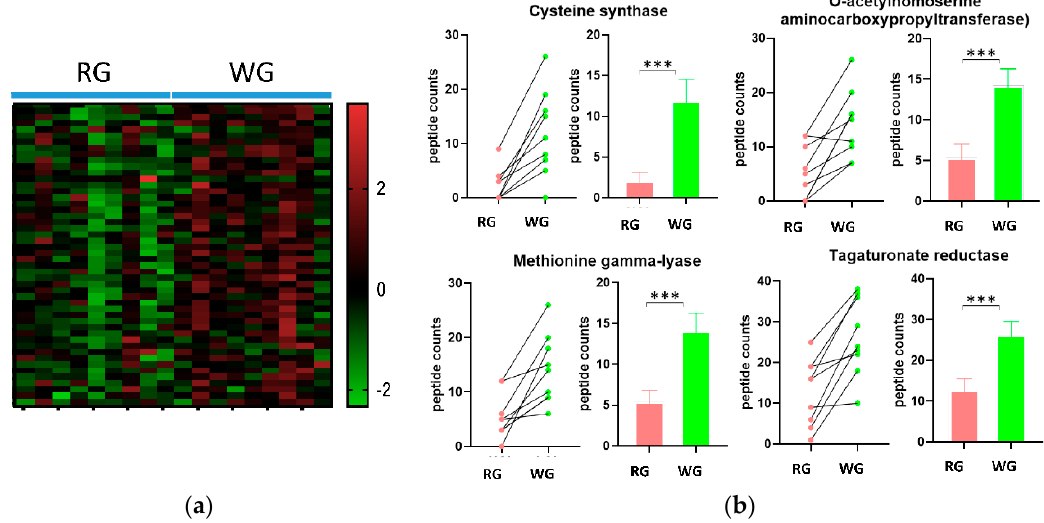
Figure 5. Significant differences in GO biological processes by diet. ( a ) Heatmap of the enzymes; ( b ) The top four enzymes with the highest fold change by diet. *** p < 0.001.